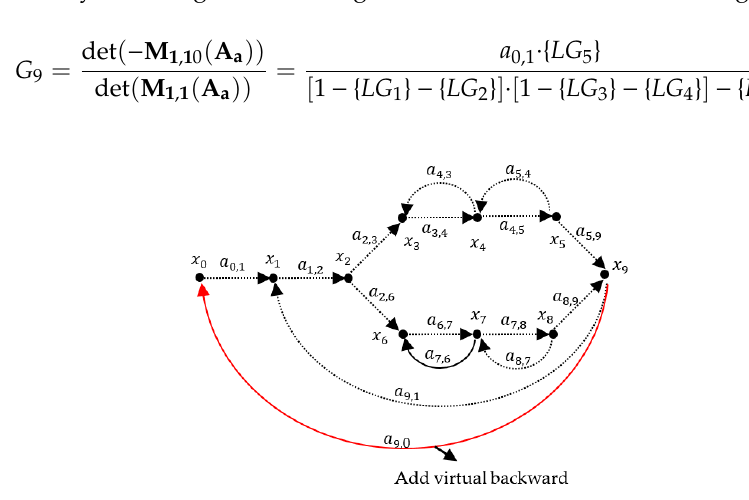
Figure 6. The forward path gain of the virtual loop group around the entire system for example 2.